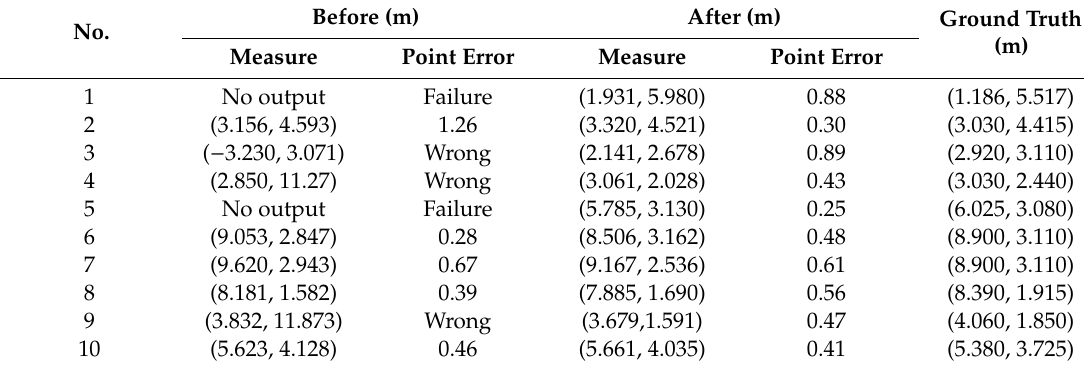
Figure 15. Ten experimental smartphone positioning images. Table 1. Comparison of positioning Table 1. Comparison of positioning results.